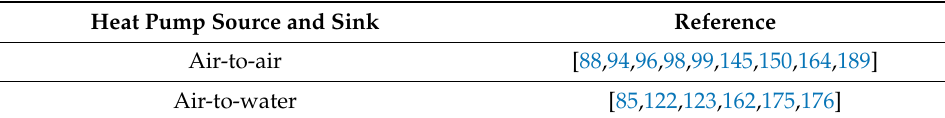
Table 5. Field tests: heat pump source and